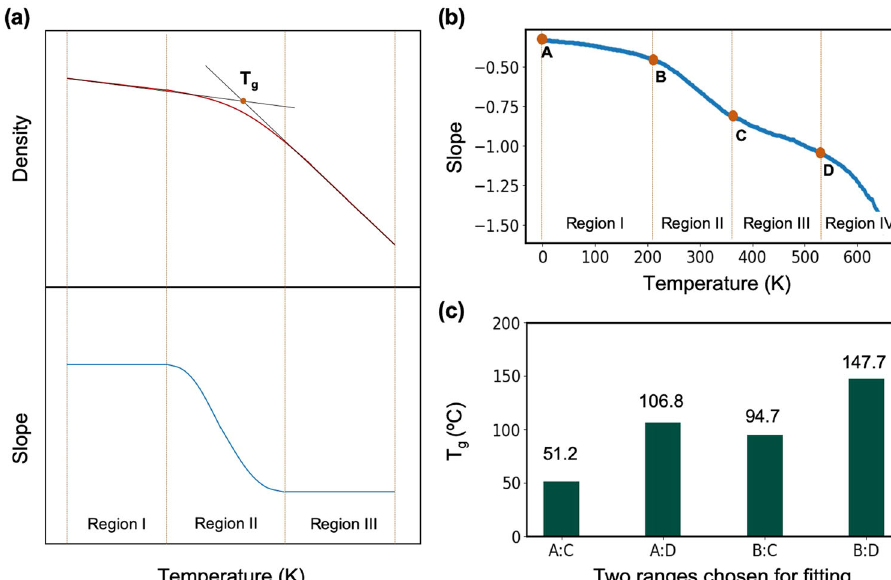
Fig. 2 Derivation of T g via a bilinear fi t. a A schematic illustration of a density – temperature and a slope – temperature plot characterizing a glass transition process. b Slope – temperature plot of BCP molecule. Each blue point on the plot represents a slope from a linear regression within the temperature range of [ T , T + 150]. Four regions and corresponding edge points, A, B, C, D, are speci fi ed. c Fitted T g using four different combinations of fi tting